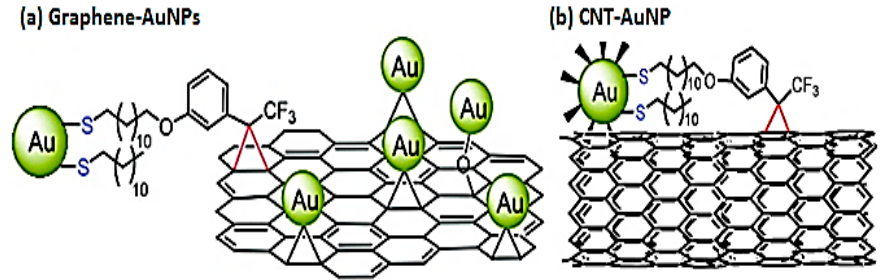
Figure 1. ( a ) Decoration of AuNPs on graphene. Adapted from [23], with permission from ©2011 American Chemical Society; ( b ) Covalent attachment of AuNP on CNT. Adapted from [24], with permission from ©2011 American Chemical Society.